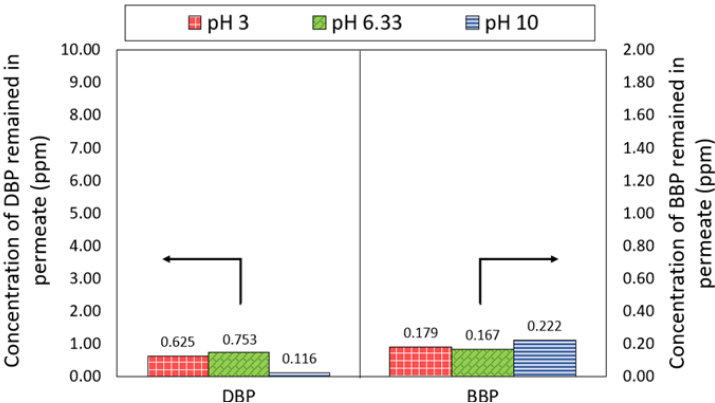
Figure 7. Concentration of DBP and BBP in the permeate of NF3 membrane.